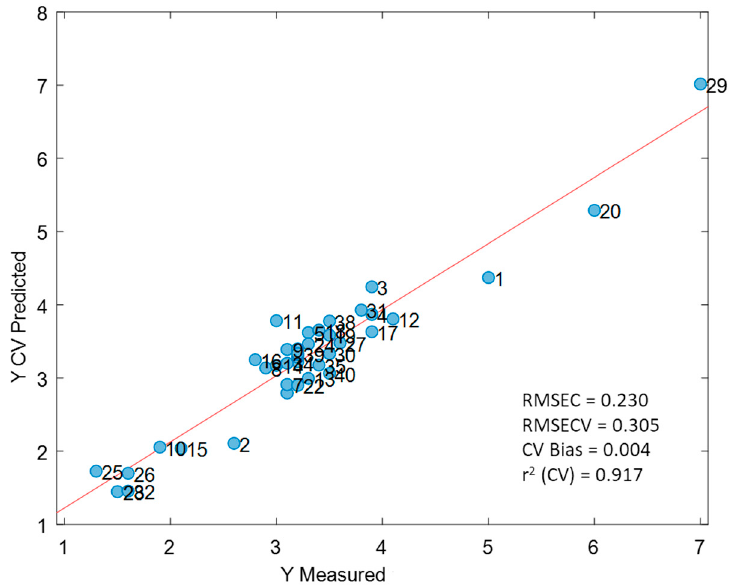
Figure 7. Regression line between the measured and predicted protein contents for SCiO.